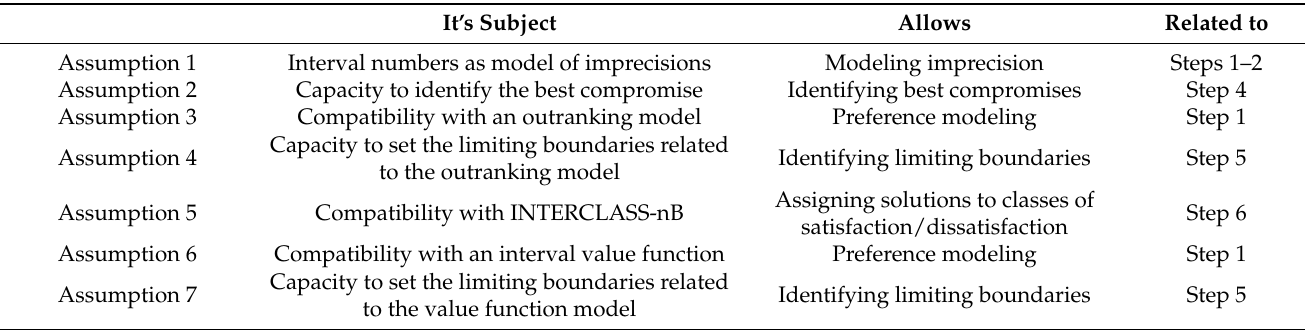
Table 1. Summary of